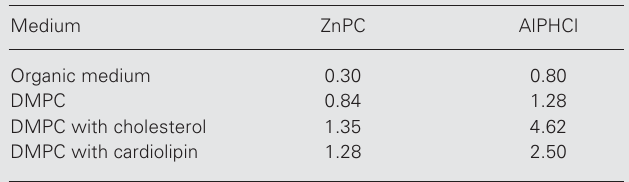
Table 4. Triplet lifetimes ( τ T ) of ZnPC and AlPHCl in organic and liposomal medium in the presence of O 2 .